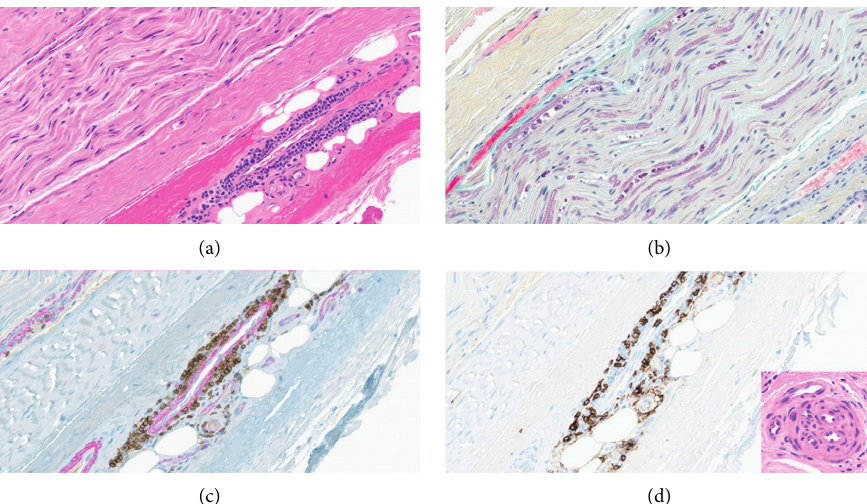
Figure 1: Right sural nerve biopsy. (a) Hematoxylin and eosin staining shows a small caliber vessel in the perineurium surrounded and focally invaded by mononuclear cells, indicative of active ongoing vasculitis. On the top left corner, the longitudinal section of the nerve with significant paucity of myelinated axons. (b) MOVATpentachrome staining shows several degenerating axons (purple globules), indicative of active ongoing axonopathy; in addition, there is a significant loss of myelinated axons with secondary endoneurial fibrosis (pale-tan material around remaining myelinated axons). (c) Double immunostaining CD3 (brown) smooth muscle actin (red) shows several T cells sur- rounding, focally invading, and disrupting the vessel wall. (d) CD20 shows admixed B cells. Inset shows the cross section of a reanalyzed vessel indicative of remote, healed vascular